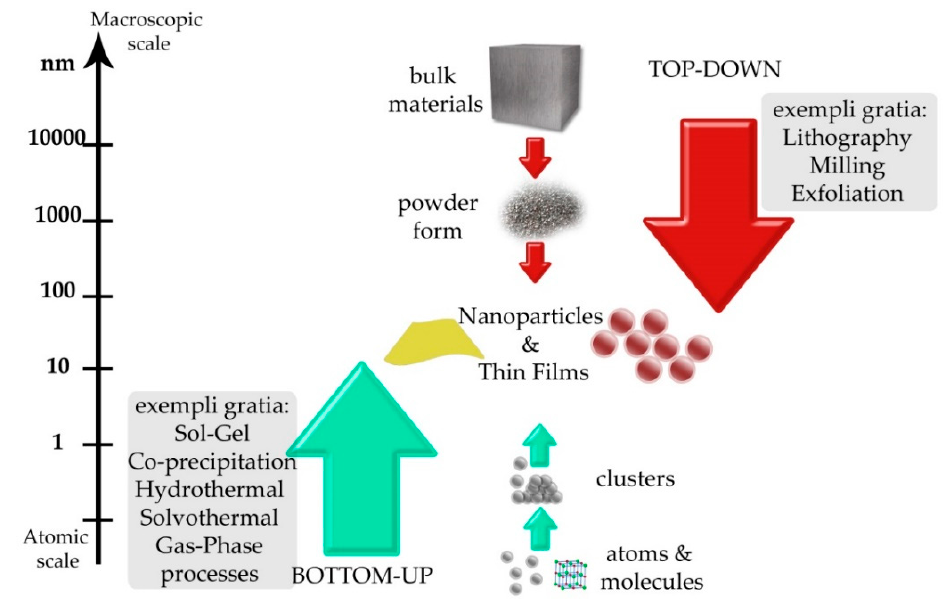
Figure 1. Top-down and bottom-up processes.